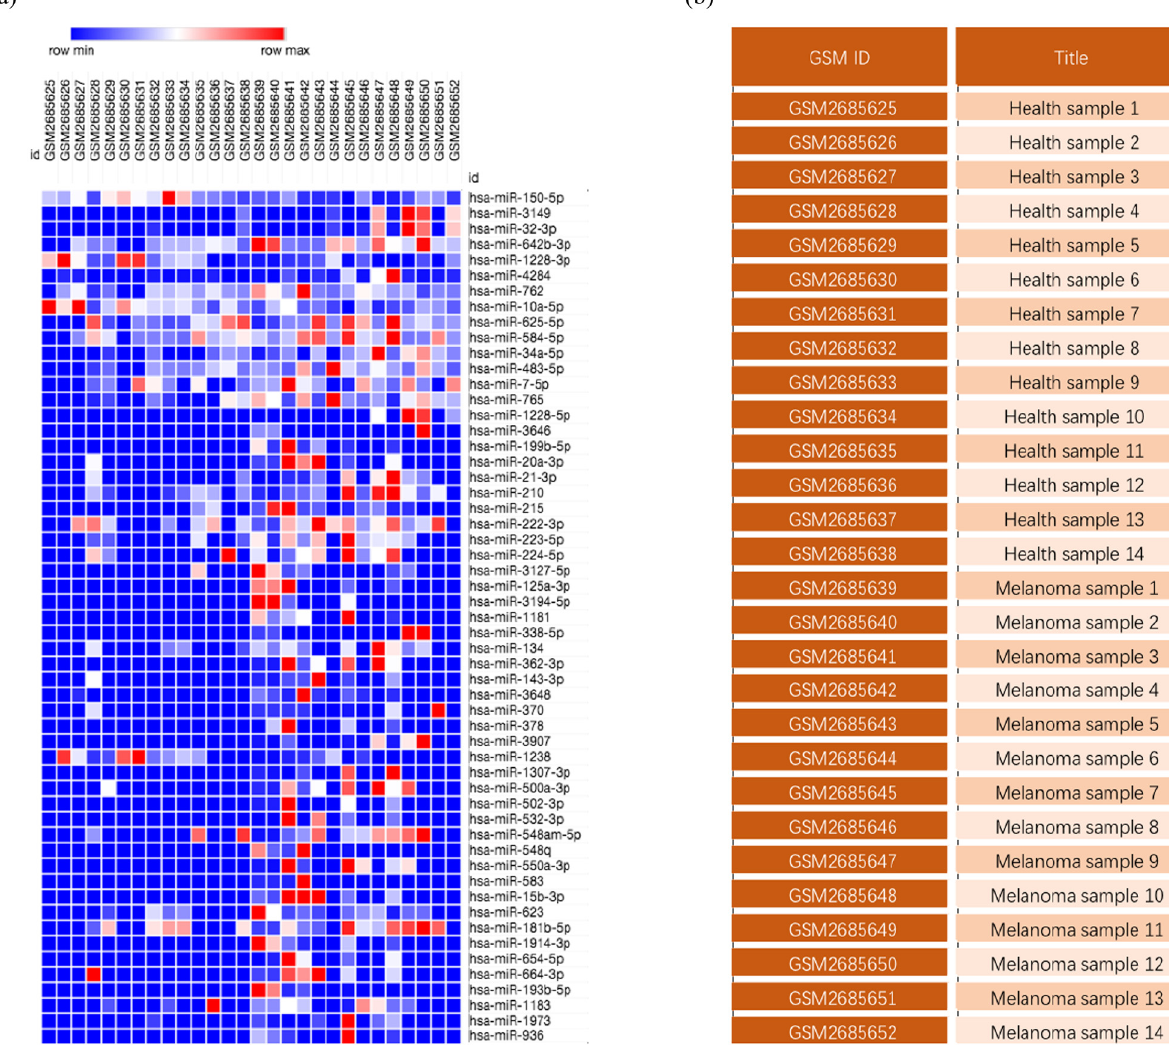
Figure 2: Di ff erential analysis of the miRNA expression in pEVs of melanoma. ( a ) Heat map of DE - miRNAs in 14 cases of melanoma and 14 health controls. ( b ) The details of the 28